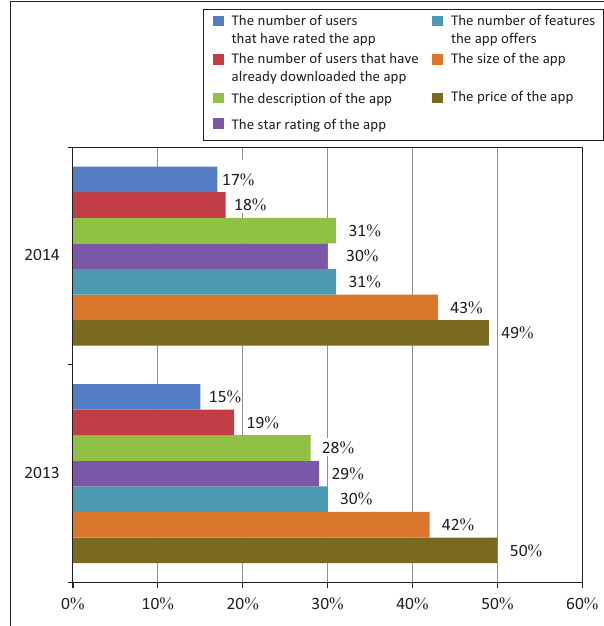
FIGURE 4: Considerations before downloading an app, 2013 vs.